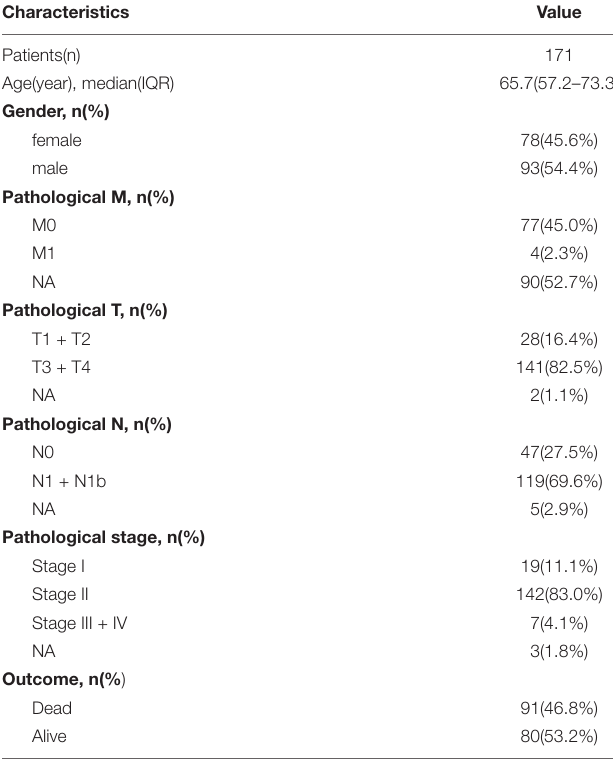
TABLE 1 | The disease-related clinical information of patients with pancreatic cancer included in the study.